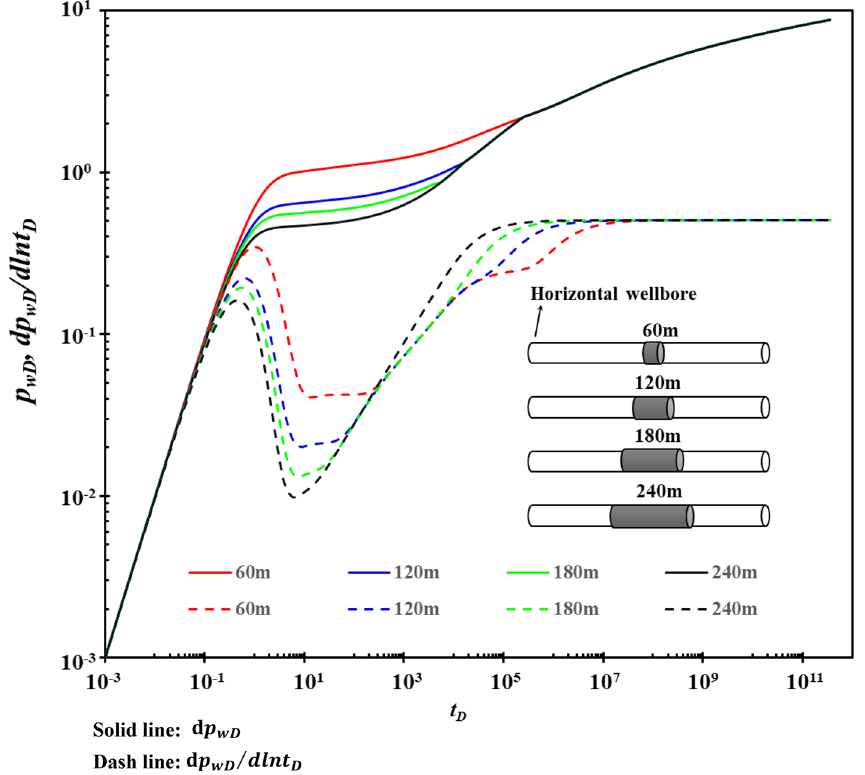
Figure 10. The effect of section length on type